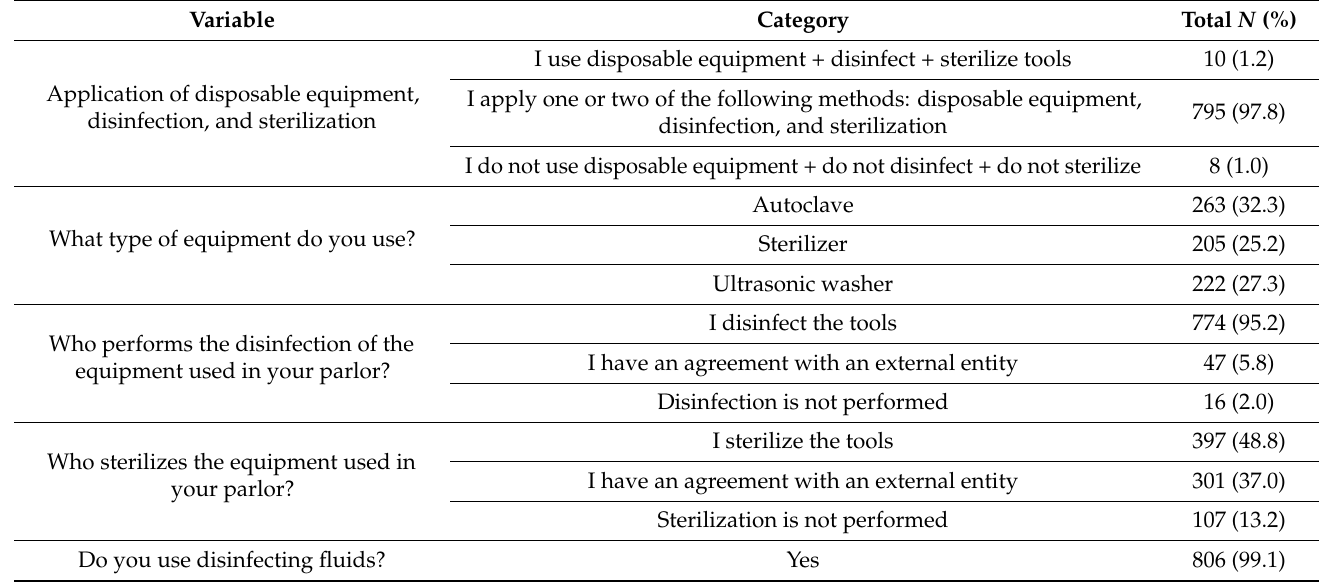
Table 1. Equipment, disinfection, and sterilization—detailed results.